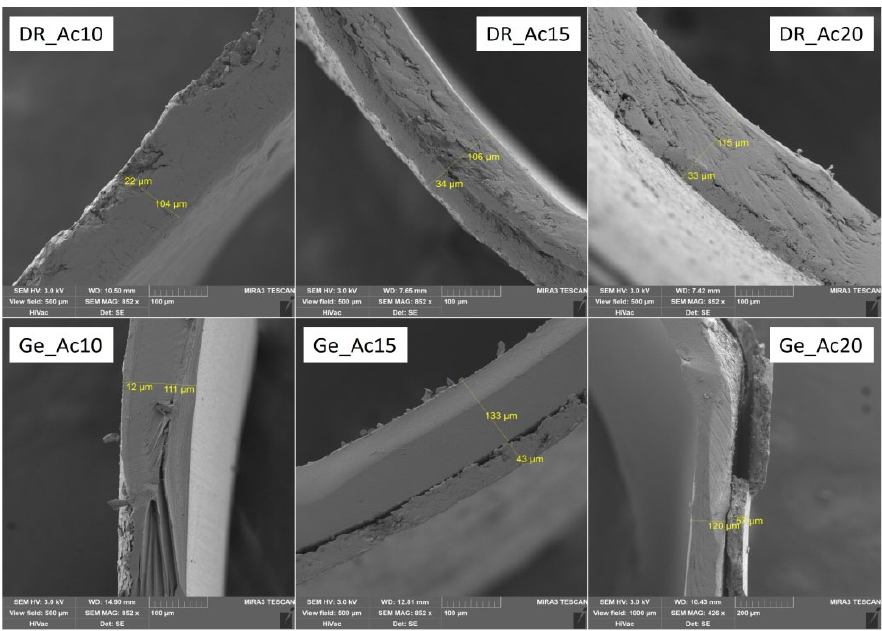
Figure 1. SEM images of selected samples with Acryl-EZE ® coating on both types of capsules.